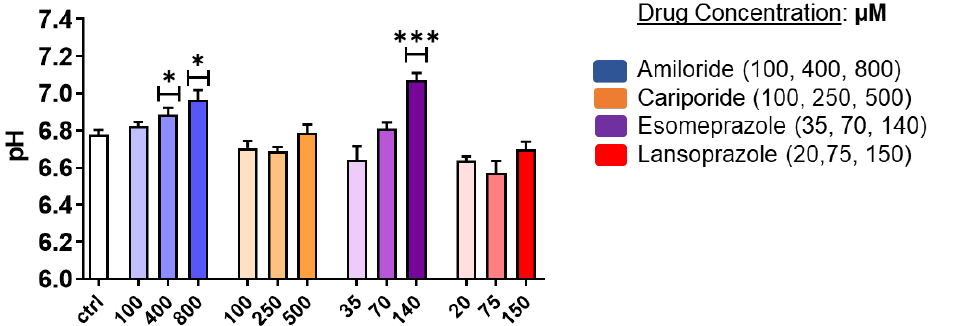
Figure 2. Extracellular pH measurements for PC3 prostate cancer cells after 24 h treatment with Amiloride, Cariporide, Esomeprazole, and Lansoprazole at different concentrations in normoxic conditions. ANOVA statistical analysis with Bonferroni post-hoc correction was assessed (* p value < 0.05; *** p value < 0.001).